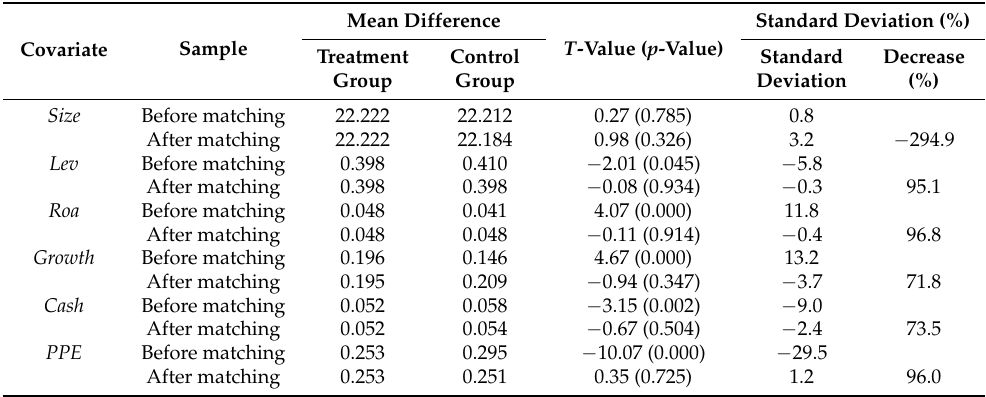
Table A4. Equilibrium hypothesis testing: propensity score